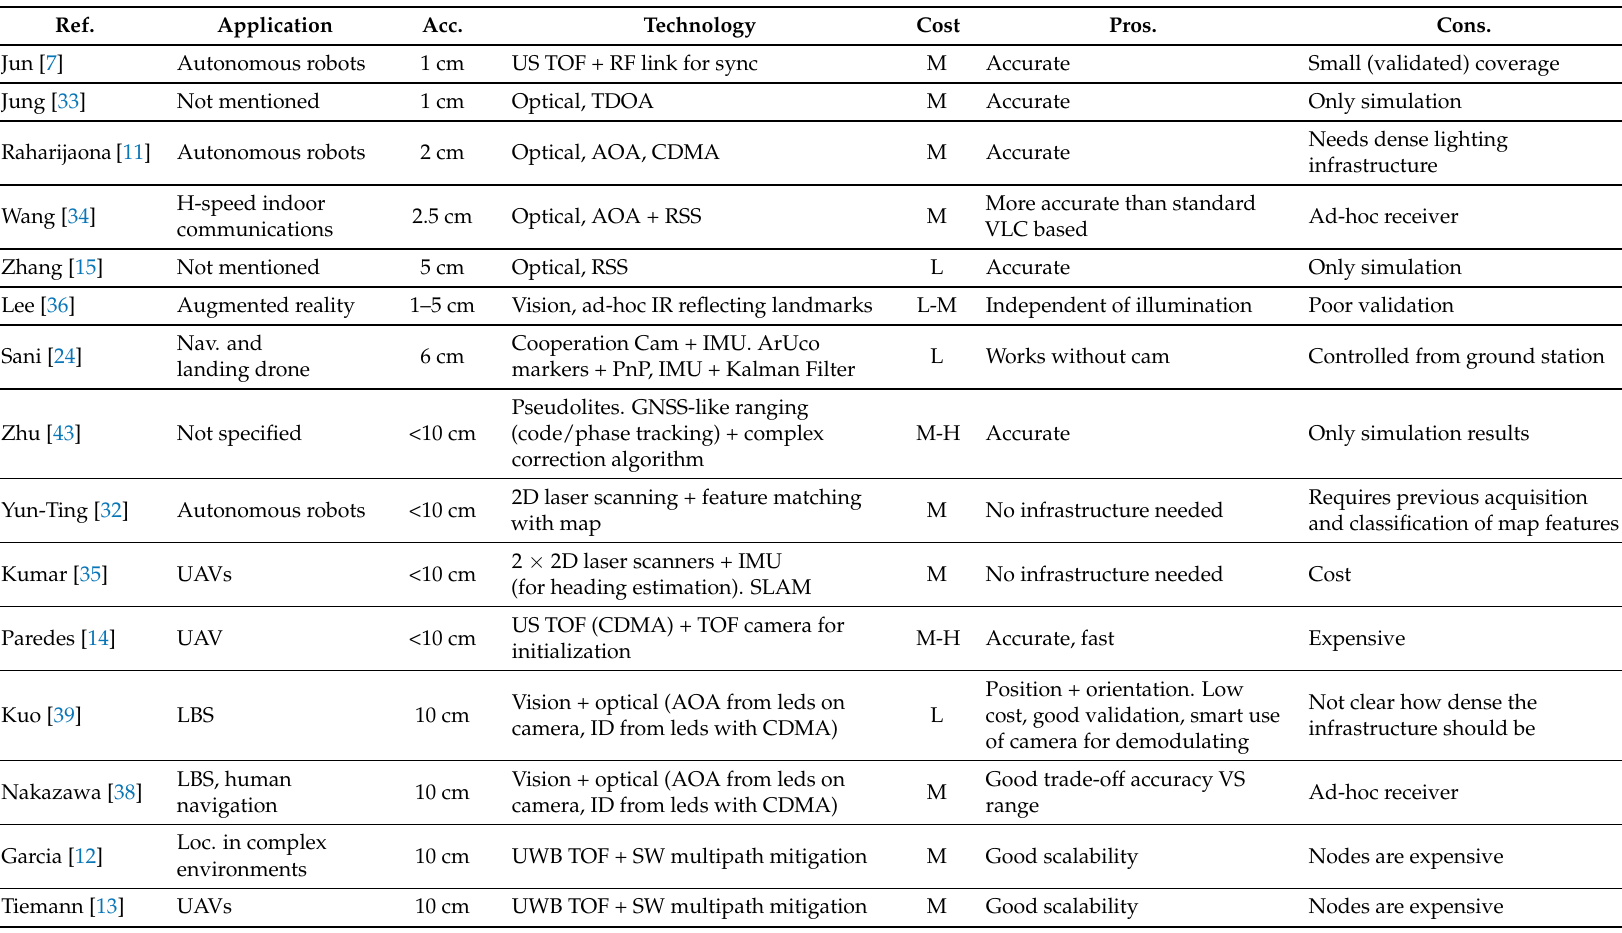
Table 1. Indoor positioning review. Cost: Low (L), Low-Medium (L-M), Medium (M), Medium-High (M-H) and High (H).